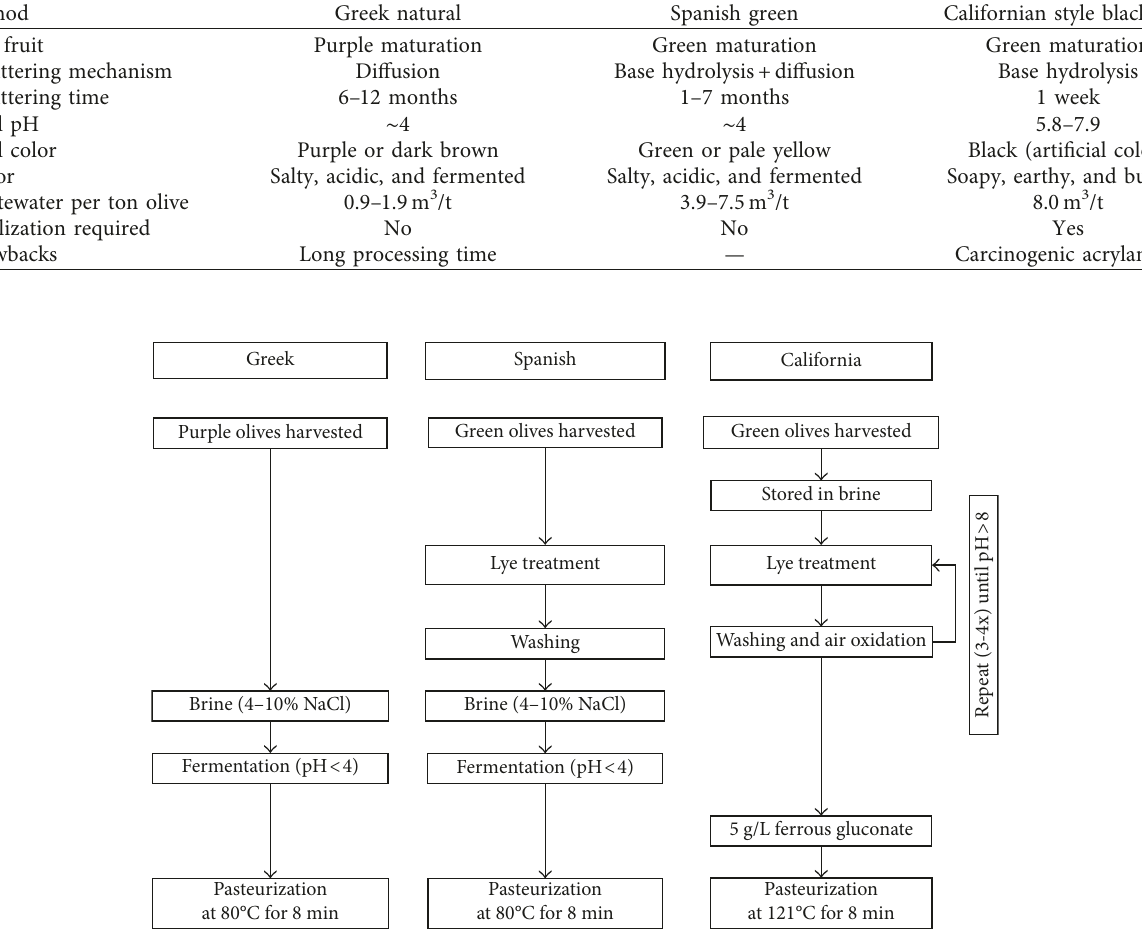
Figure 1: Diagram of Greek natural, Spanish green, and California style black ripe table olives processing